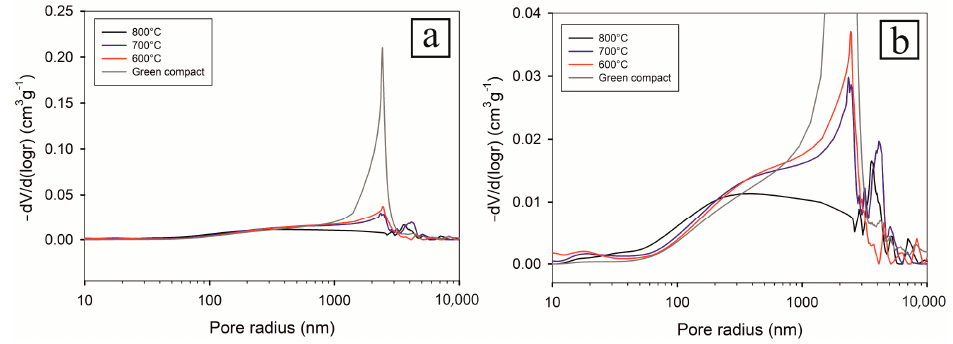
Figure 14. Pore size distribution after oxidation at 600 °C, 700 °C and 800 °C in comparison with non-oxidized green compact: whole range ( a ), detail ( b ).